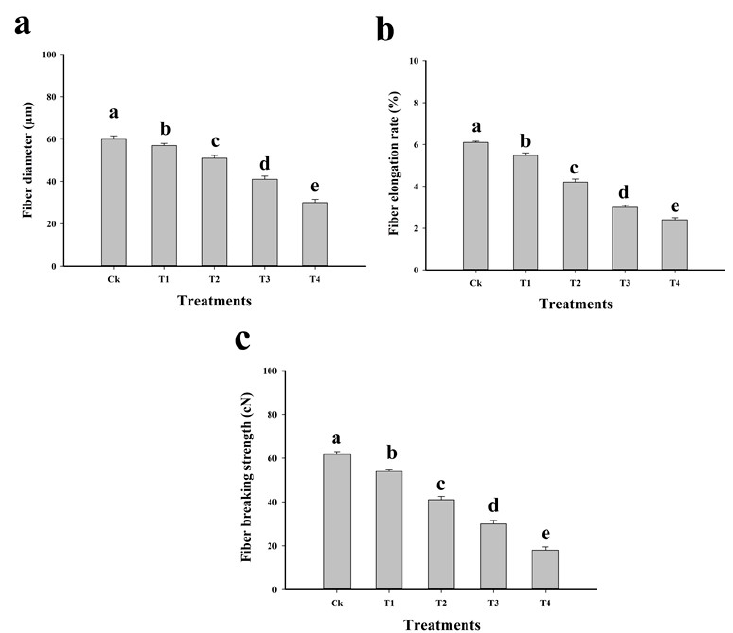
Figure 2. Effect of different levels of Cu-contaminated soil mixed with natural soil on fibre diameter ( a ), fibre elongation rate ( b ) and fibre breaking strength ( c ) of C . capsularis . Values in the figures are just one harvest. Bars sharing different lowercase letters denote significant statistical differences among the treatments at p < 0.05 according to least significant difference (LSD) test. Data shown are the average of three replications ( n = 3). Ck (soil without addition of Cu-contaminated soil), T1 (Cu-contaminated soil is mixed with natural soil by 1:4), T2 (Cu-contaminated soil is mixed with natural soil by 1:2), T3 (Cu-contaminated soil is mixed with natural soil by 1:1) and T4 (Cu-contaminated soil is mixed with natural soil by 1:0).